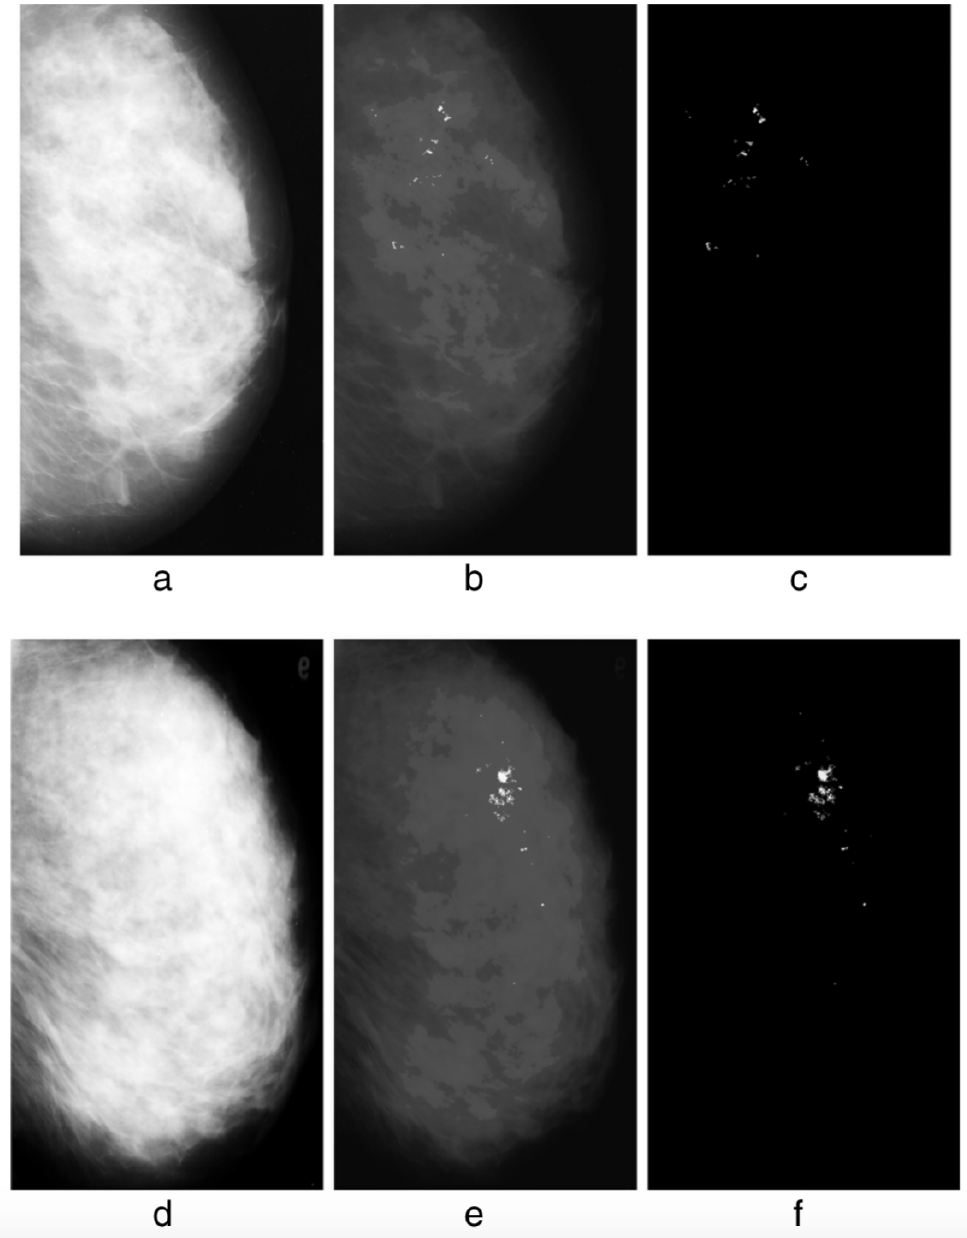
Figure 26. Without q -entropy enhancement with q (cid:54) = 1, detection of microcalcifications is meager: 80.21% Tps (true positives) with 8.1 Fps (false positives), whereas upon introduction of the q -entropy, the results surge to 96.55% Tps with 0.4 Fps. Detection results from the experiment: ( a ) mdb236, ( b ) output with the Mcs enhanced, ( c ) output with the Mcs extracted, ( d ) mdb216, ( e ) output with the Mcs enhanced, ( f ) output with the Mcs extracted. From